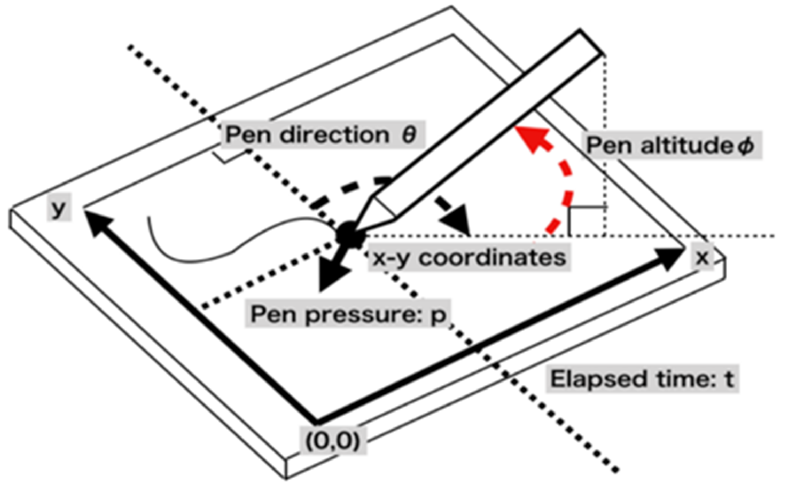
Figure 2. Pen tablet device.